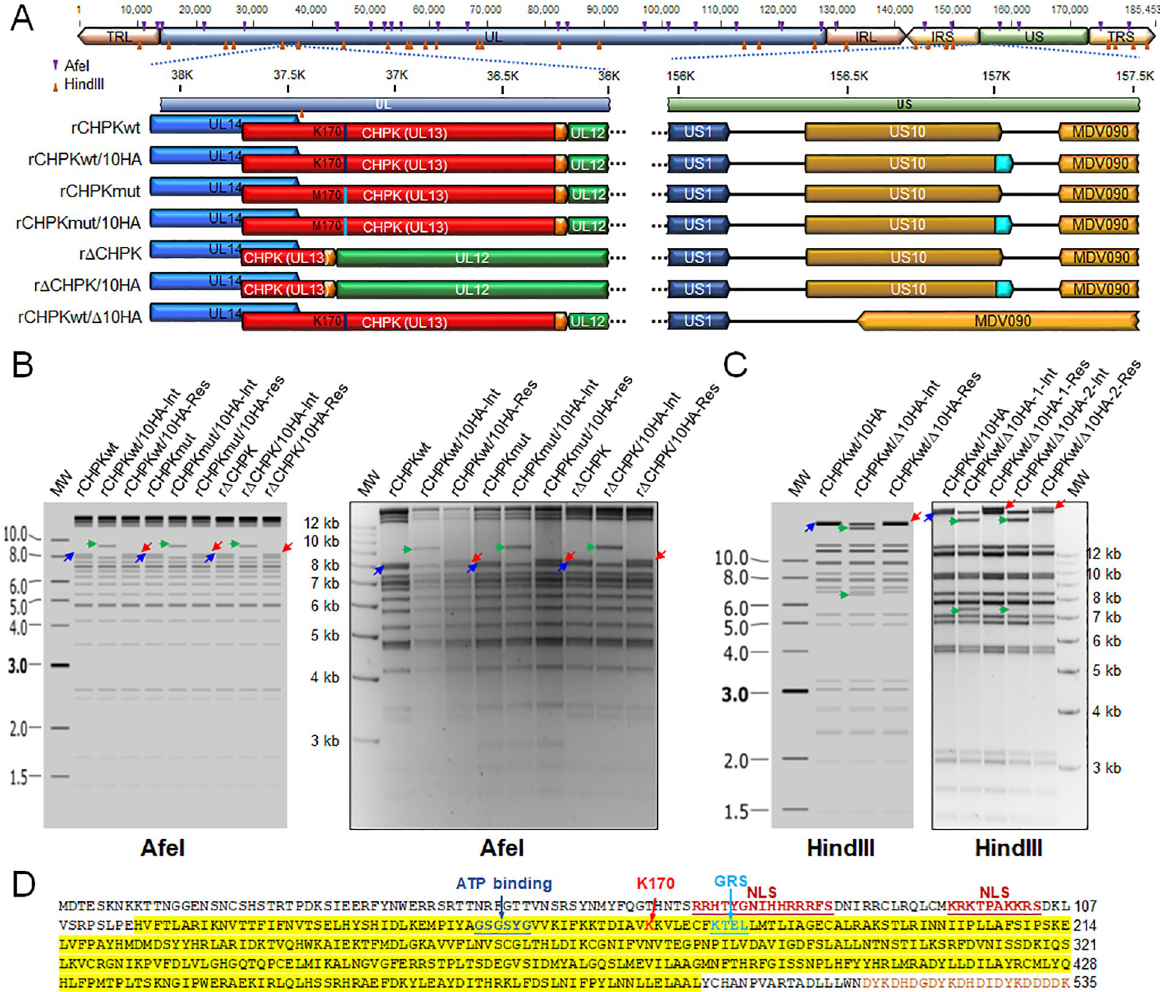
Fig 2. Generation of rMDVs. (A) Schematic representation of the MDV genome depicting the locations of the terminal repeat long (TRL) and short (TRS), internal repeat short (IRS), and unique long (UL) and short (US) regions. A portion of the UL and US regions are expanded to show the relevant genes including UL12, UL13 (CHPK), and UL14 in the UL region and US1, US10, and MDV090 in the US region. Differences between the rMDVs are shown, including the amino acid located at position 170 in pCHPK and the presence of the 3 × Flag and 2 × HA epitopes on pCHPK and pUS10, respectively. (B) Predicted and actual RFLP analysis of rMDV CHPK and US10 BAC clones. BAC DNA obtained for each parental (rCHPKwt, rCHPKmut, and r Δ CHPK), integrates (rCHPKwt/10HA-Int, rCHPKmut/10HA-Int, and r Δ CHPK/10HA-Int), and resolved clone (rCHPKwt/10HA-Res, rCHPKmut/10HA-Res, and r Δ CHPK/10HA-Res) were digested with AfeI and examined using RFLP analysis. Insertion of the I- SceI-aphAI +2 × HA cassette into the 8,055 bp fragment (right directed blue arrow) results in a 9,195 bp fragment (right directed green arrow) during integration. This fragment is then reduced to 8,121 bp fragment (left directed red arrow) during resolution and removal of I- SceI-aphAI cassette. (C) Predicted and actual RFLP analysis of rMDV Δ US10 BAC clones. BAC DNA obtained for rCHPKwt/10HA, rCHPKwt/ Δ 10HA-Int, and rCHPKwt/ Δ 10HA-Res were digested with HindIII and examined using RFLP analysis. Integration of the I- SceI-aphAI cassette into 26,782 bp fragment (right directed blue arrow) containing US10c2 × HA inserts a HindIII site creating two fragments, 20,505 and 6,600 bp fragments (right directed green arrows). Resolution removes the I- SceI-aphAI cassette and the additional HindIII site creating a 26,077 bp fragment (left directed red arrow). The molecular weight marker used was the GeneRuler 1 kb Plus DNA Ladder from Thermo Scientific (Carlsbad, CA). No extraneous alterations are evident. (D) MDV pCHPK with C-terminal 3 × Flag tag (brown letters). Yellow highlighted area indicates protein sequence deleted in v Δ CHPK/10HA. The invariant lysine (K170) and ATP binding sites are noted [96, 97]. Putative nuclear localization signals (NLS) and Golgi retention sequence (GRS) were identified based on previous studies [98–100]or predicted using NLStradamus [101] and MyHits